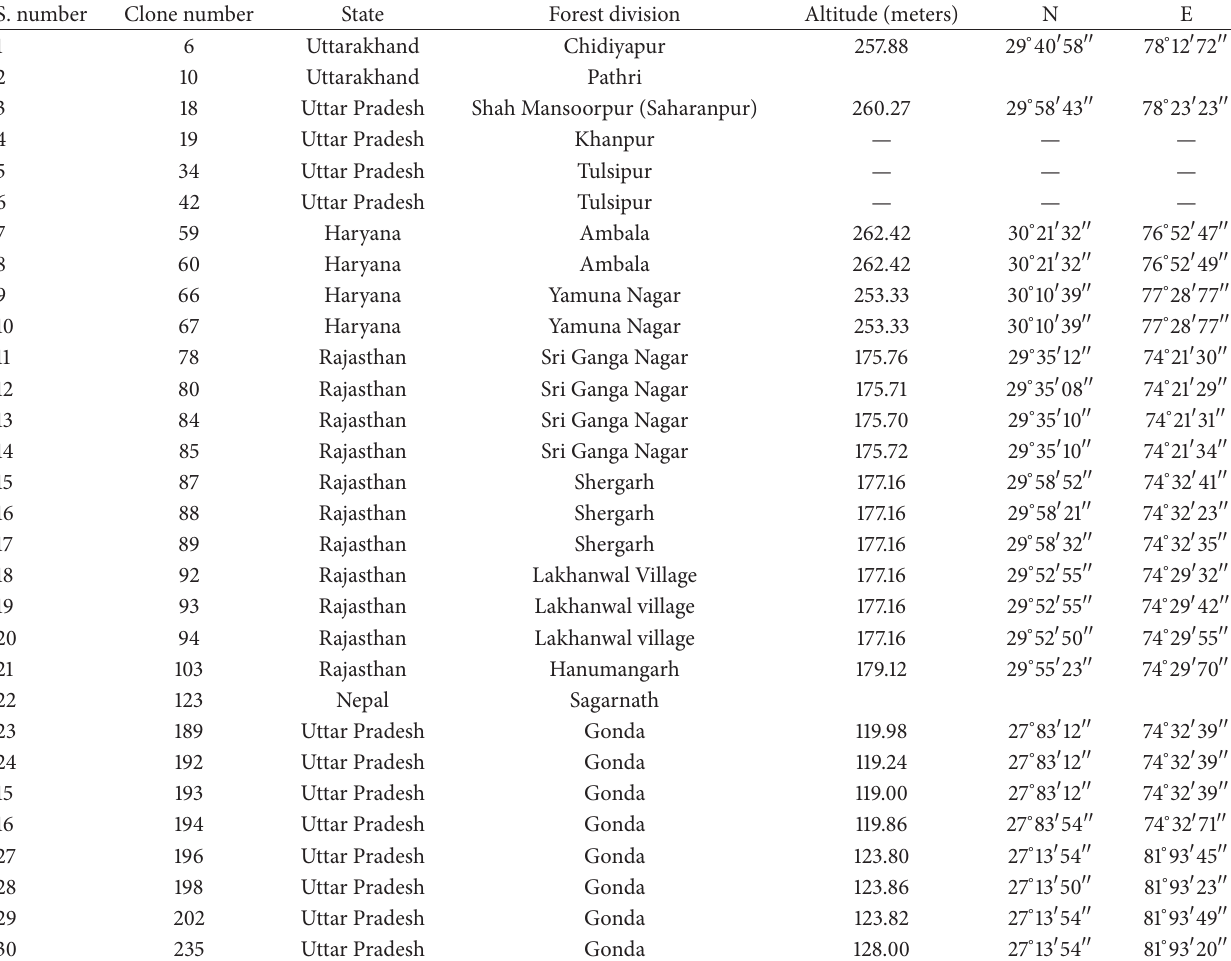
Table 1: Geographical details of Dalbergia sissoo clones planted in clonal seed orchard. S.